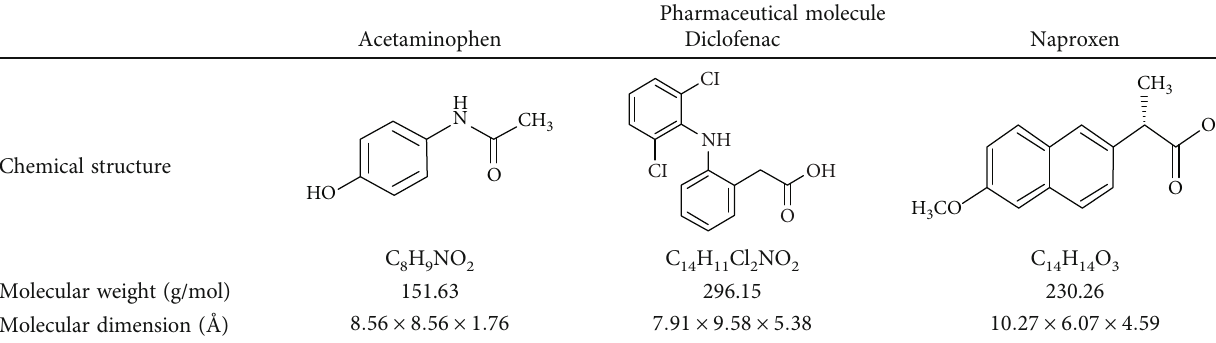
Table 1: Main characteristics of the naproxen, diclofenac, and acetaminophen molecules used as adsorbates in this